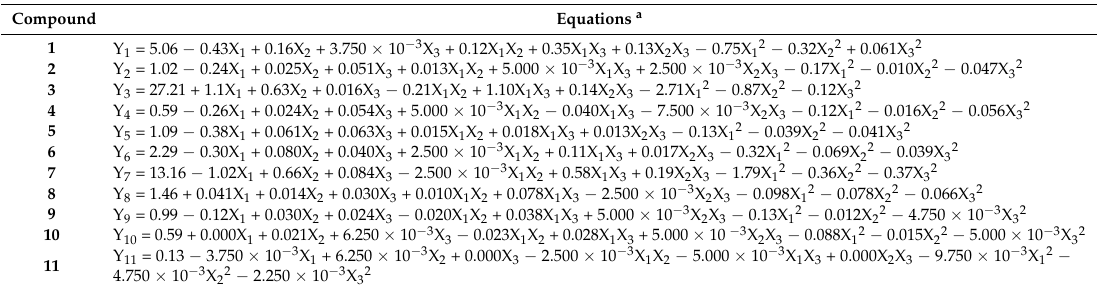
Table 2. Equations of 11 responses in terms of coded